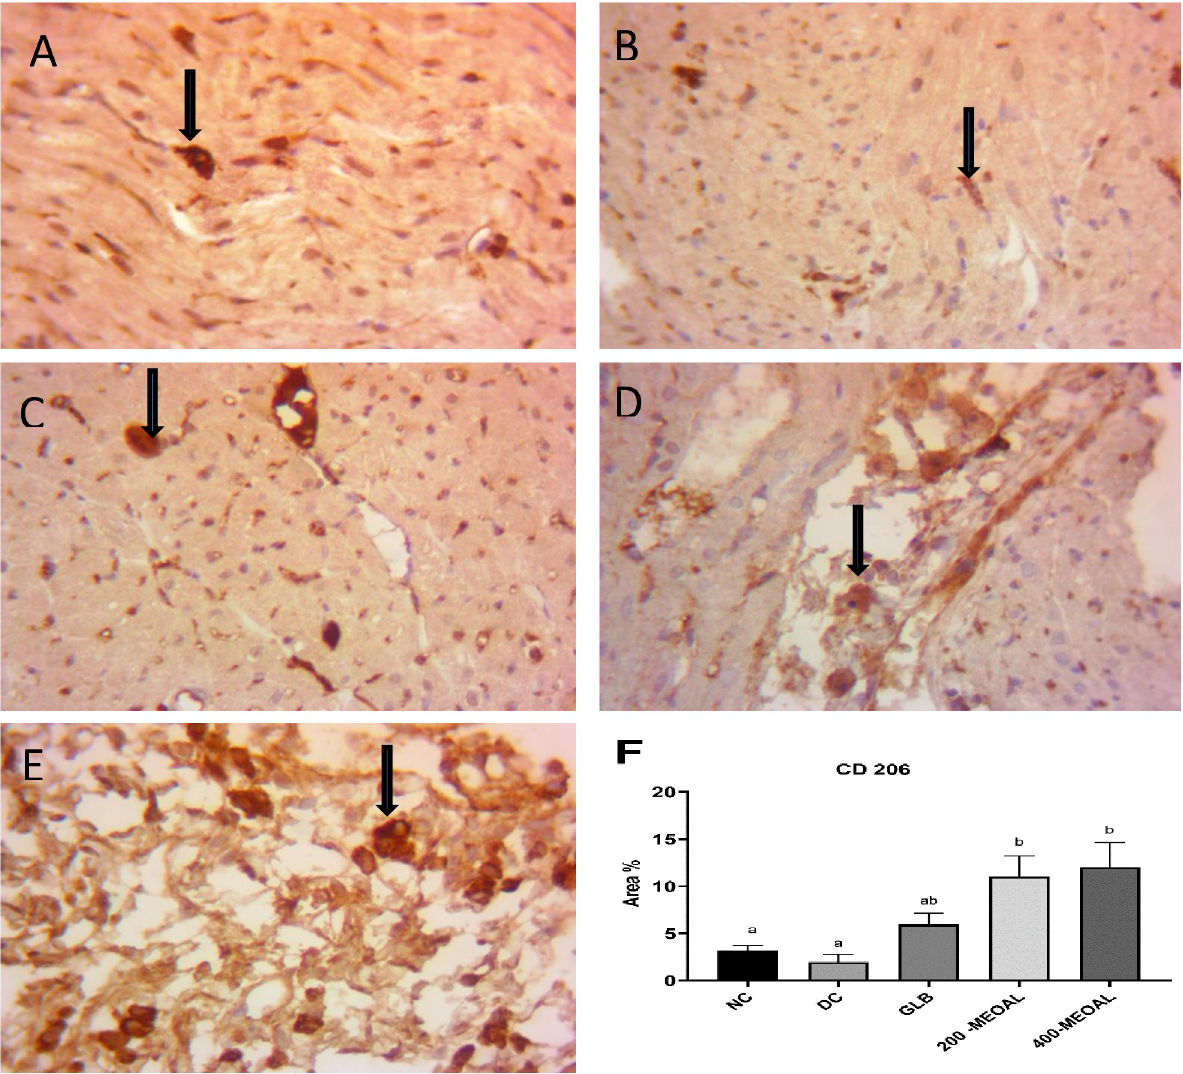
Fig 6. Effect of GLB or MEOAL on CD206 cells positivity in the myocardium macrophage in different groups. MRC1 Immunohistochemical staining (40X). https://doi.org/10.6084/m9.figshare.21828903.v1. Myocardium section from (A) Normal control group showing few expression of CD206 cells positivity (arrow); (B) Diabetic control group showing few expression of CD206 cells positivity (arrow); (C) Diabetic GLB(5mg/kg) treated group showing increase in CD206 cells positivity (arrow) compared to DC (P > 0.05,F);(D) Diabetic MEOAL (200mg/kg) treated group showing significant increase in CD206 cells positivity (arrow) compared to DC (P < 0.05,F); (E) Diabetic MEOAL (400mg/kg) treated group showing significant increase in CD206 cells positivity (arrow) compared to DC (P < 0.05,F). F: The bar chart represents MRC1 immunopositive staining expressed as area%. The results are expressed as mean ± SEM (n = 8). P-value was calculated using ANOVA with Post Hoc Tukey test. The same letters mean no significant difference, the different letters (a, b) mean a significant difference at P < 0.05. Abbreviations: NC; normal control group. DC; diabetic control group. GLB; 5mg/kg glibenclamide treated group .200or 400- MEOAL; 200 or 400mg/kg O . acanthium extract treated groups respectively. 42, Gln 461, and Cys 47. The other amino acids residue in the binding pockets are Arg 469, Pro 153, and Cys 47 by pi-alkyl and Arg 44 by pi-hydrogen interaction (Fig 9). Kaempferol, and Epicatechin showed favourable binding energy ranging from -8.7 kcal/ mol to -7.6 Kcal/mol compared to the reference drug Glibenclamide with -7.7 Kcal/mol.